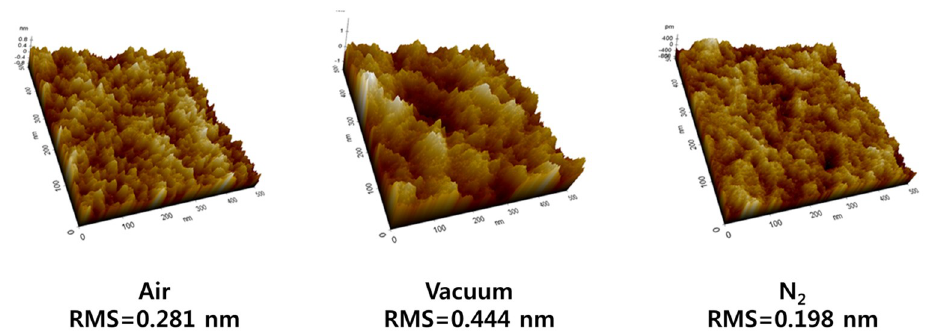
Figure 2. SPM images of ZrO 2 thin films annealed in air, vacuum, and N 2 .